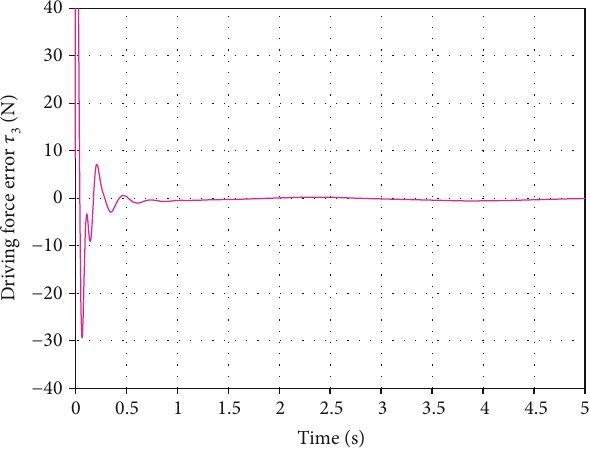
Figure 8: The position error of the third actuated joint d